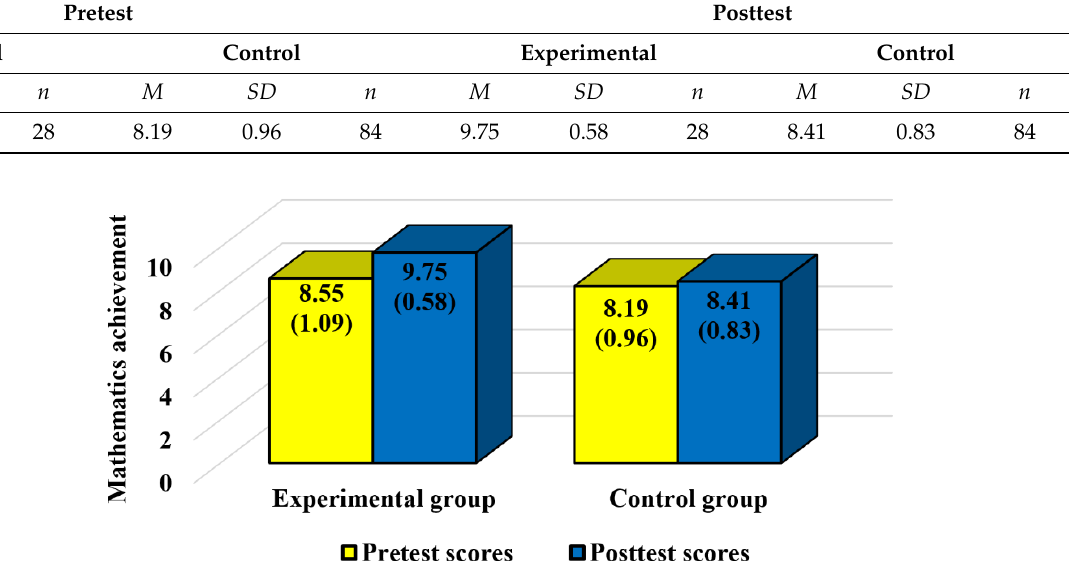
Table 1. Overall descriptive mathematics achievement results for the experimental and control groups.